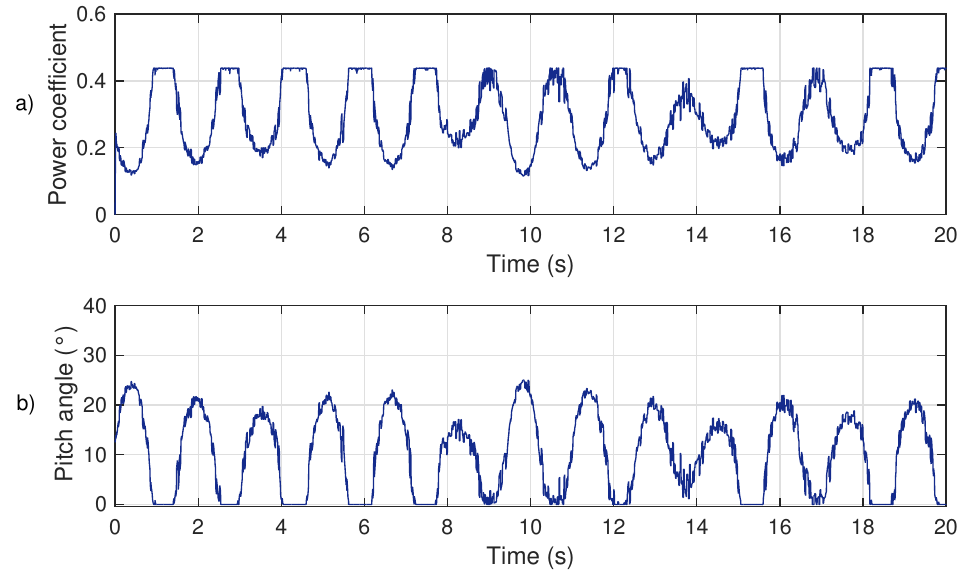
Figure 21. Control performances of case 2: ( a ) power coefficient variation; ( b ) pitch angle